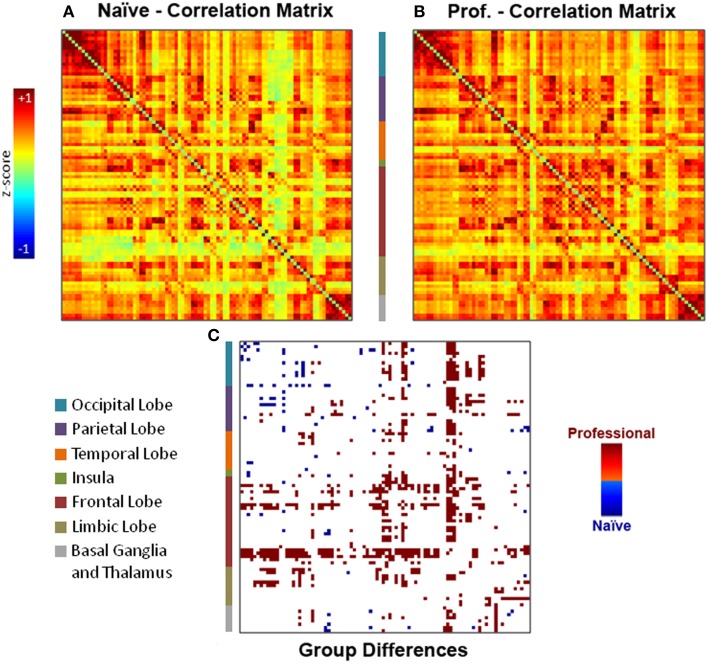
Individual functional connectivity matrices obtained with the explorative approach were used to compute (A–B) group averaged matrices and (C) a comparison between professional and naïve drivers via unpaired t-test (p < 0.05). Results showed a number of reinforced correlations in professional as compared to naïve drivers, mostly in prefrontal cortex (orbitofrontal cortex, superior frontal gyrus), basal ganglia and cingulate cortex. On the other hand, naïve drivers showed fewer stronger correlations, mostly between areas belonging to occipital and parietal lobes.